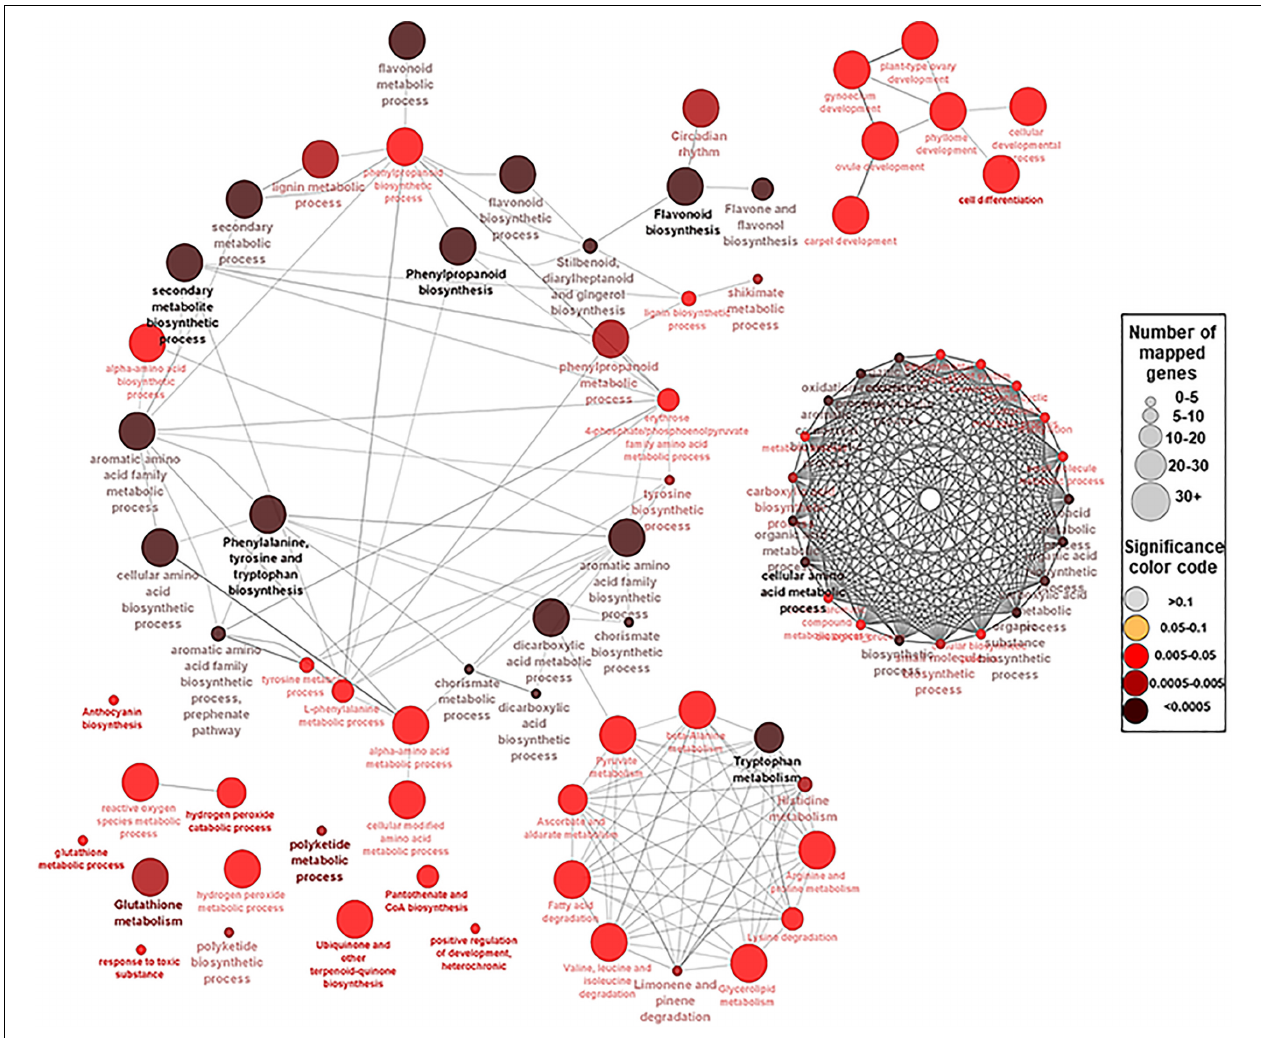
FIGURE 3 | A network view for the predefined biological processes Gene Ontology (GO) terms and Kyoto Encyclopedia of Genes and Genomes (KEEG) pathways for the 94 hub genes. BP GO terms and KEEG pathways for the selected 94 genes ( p -adjusted < 0.05), extracted by g:Profiler website with Benjamini–Hochberg false discovery rate (FDR) multiple testing correction method. The default ClueGO settings were applied, and the terms are functionally grouped based on shared genes (kappa score). The size of the nodes indicates the number of mapped genes ranged from 0–5, 5–10, 10–20, 20–30, and ≥ 30 genes. The size of the nodes indicates the number of mapped genes, while the color indicates the degree of significance (0.1 < p -value < 0.0005). The most significant term defines the name of the